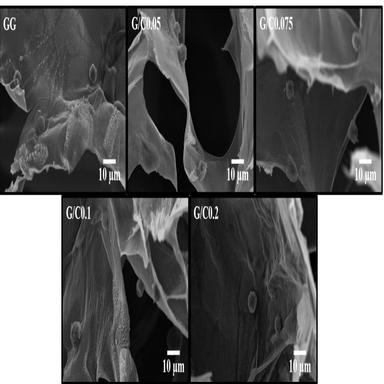
SEM images of chondrocytes encapsulated in the hydrogels.